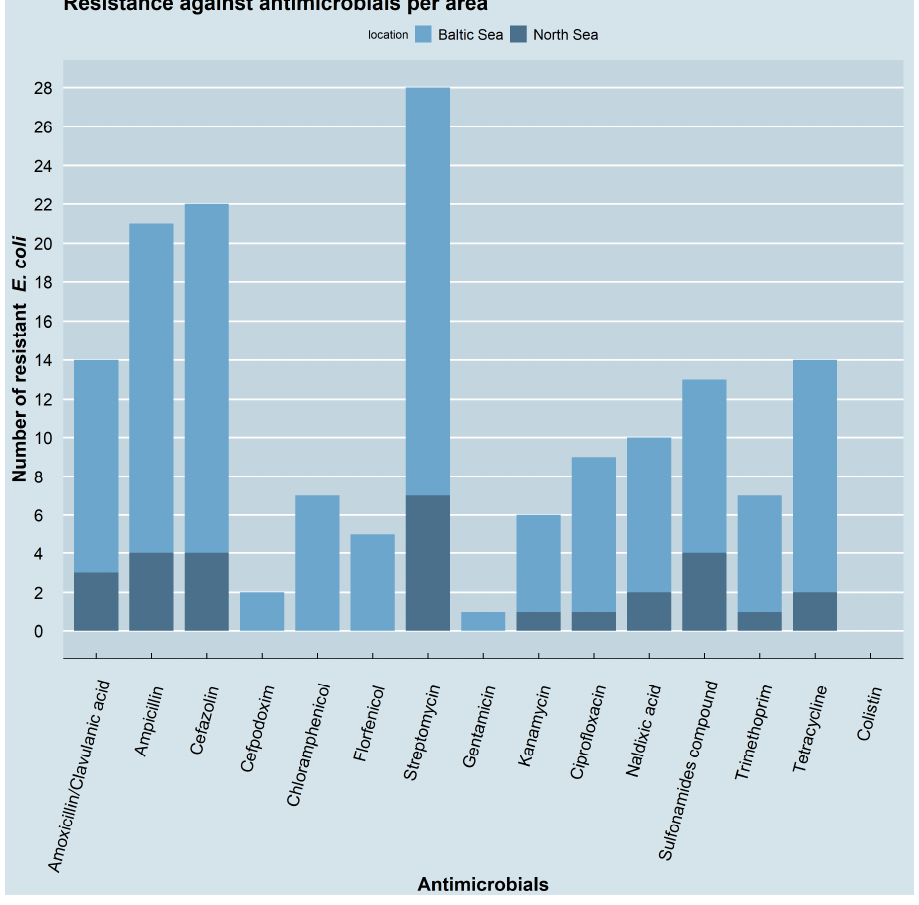
Figure 4. Resistance against antimicrobials by location. The number of resistant E. coli isolates is shown for each of the tested antimicrobials. The proportion of the two locations is indicated by different colours with blue for the Baltic Sea and dark blue for the North Sea. Isolates with more than one resistance are included multiple times. The figure was created using RStudio version 1.4.1103 (R version 4.1.2) with the package ggplot2.